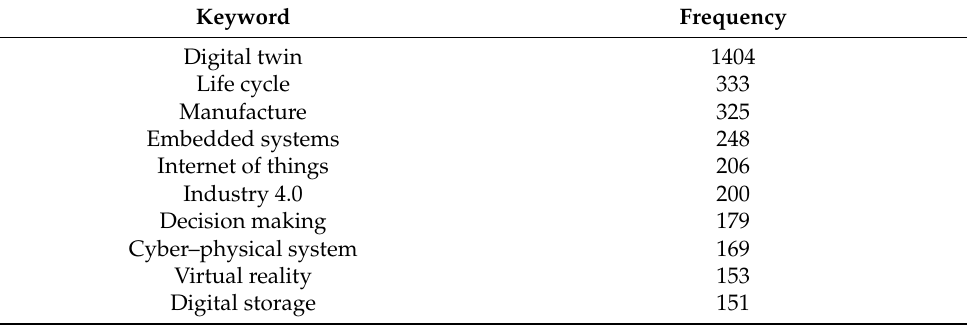
Table 2. Top ten most frequent index keywords in the DT research field.